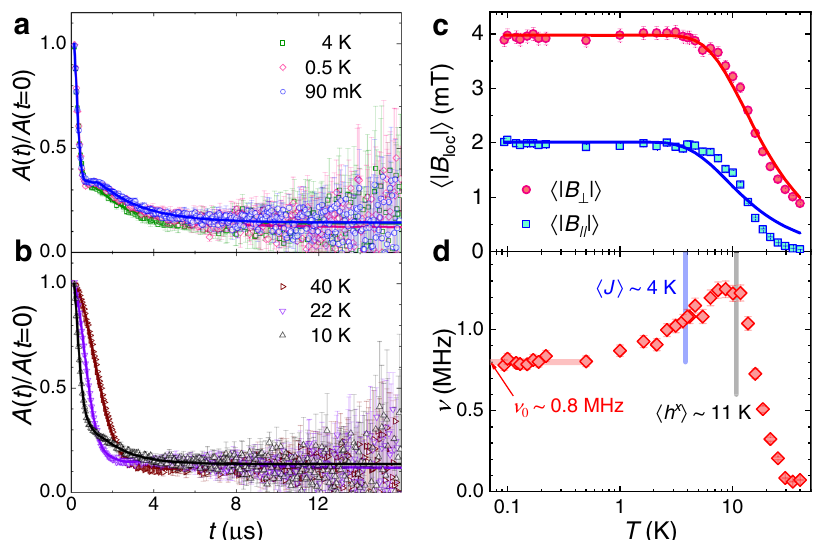
Fig. 2 µ SR measured on the single crystal of PrTiNbO 6 . a , b Selected ZF- µ SR spectra with the incident beam perpendicular to the c axis in the dilution refrigerator and 4 He cryostat, respectively. The colored lines represent the Gaussian DKT fi ts. c Temperature dependence of the average absolute value of the local- fi eld components perpendicular ( ‹ | B ⊥ | › ) and parallel ( ‹ | B || | › ) to the incident beam, with the colored lines showing the fi ts (see main text). d Temperature dependence of the fl uctuation rate of the local fi eld around the implanted µ + . Error bars on the data points show a standard